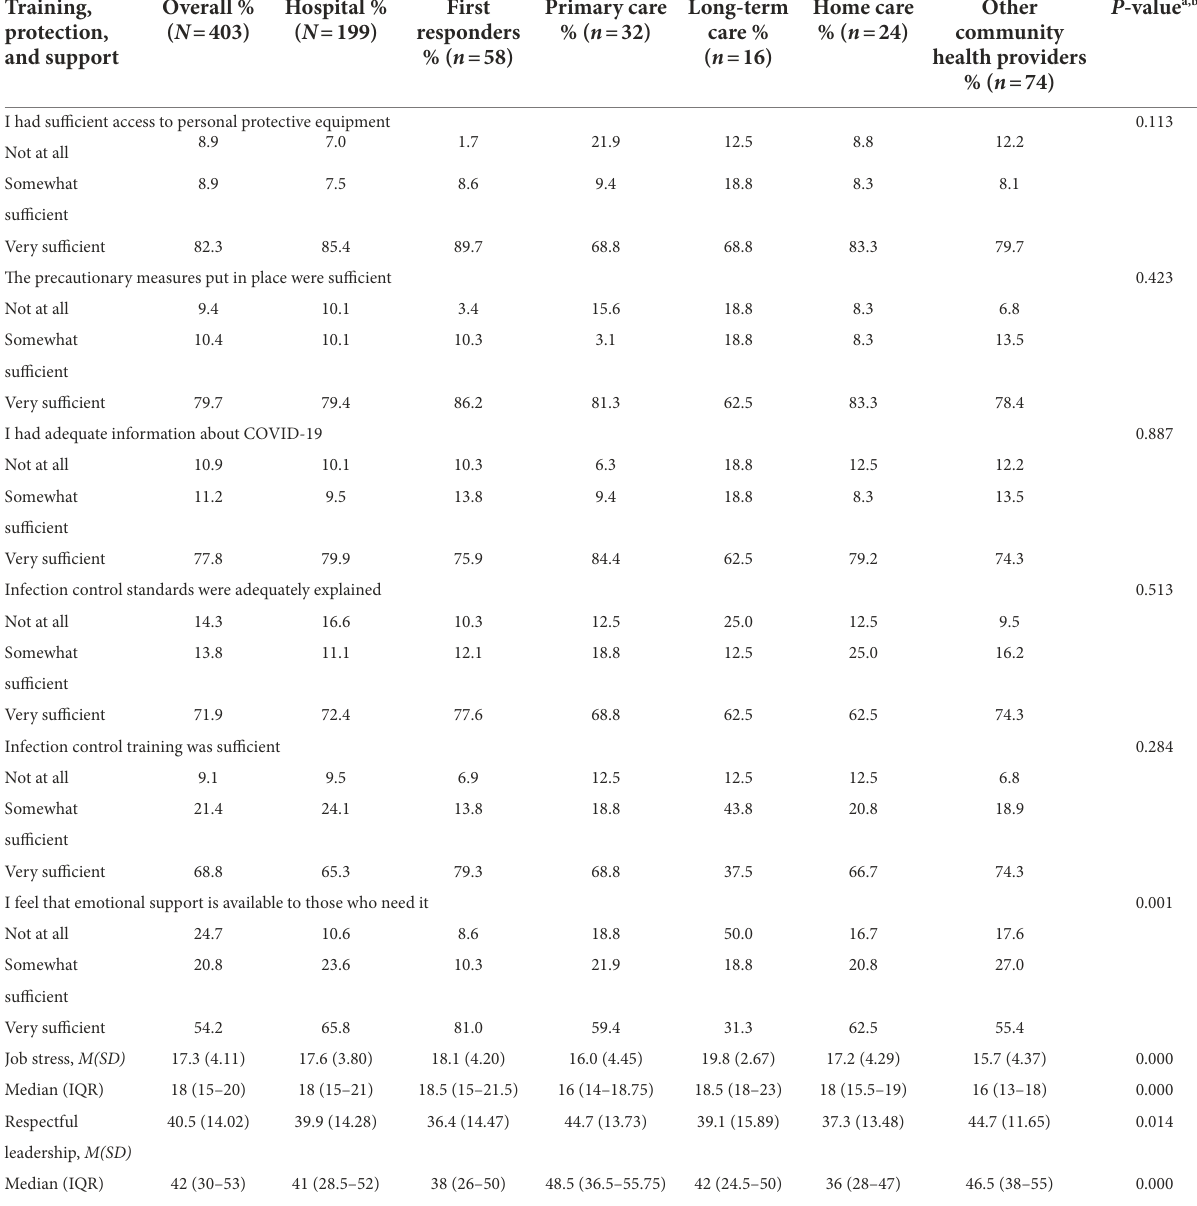
TABLE 3 Training, protection, and support reported by overall sample and by healthcare